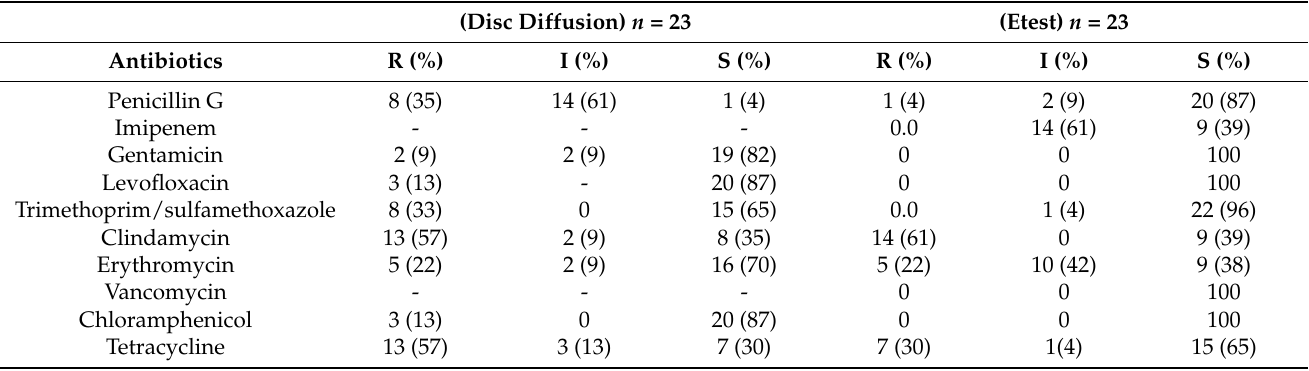
Table 5. Antimicrobial resistance of Listeria species isolated from raw dressed broilers ( n = 23). (Disc Diffusion) n =